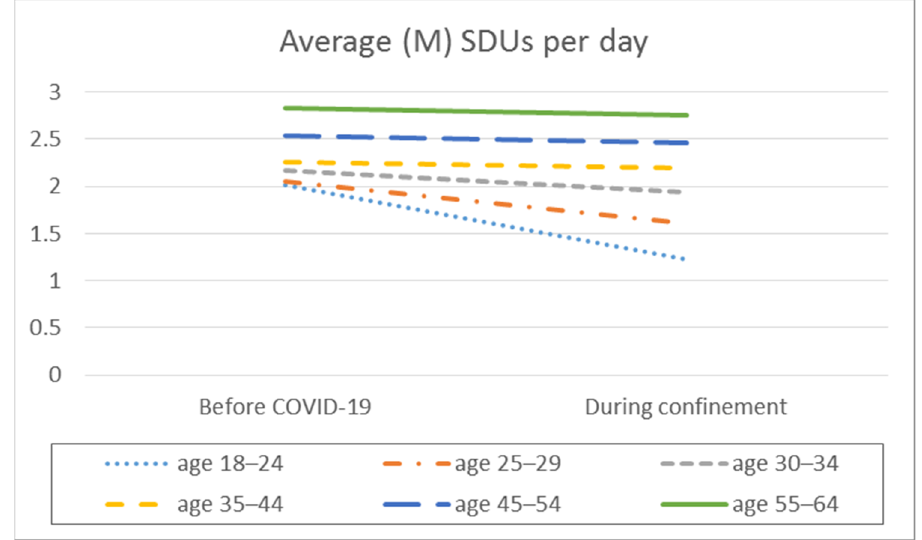
Figure 4. Average number of SDUs per day by age before the pandemic and during COVID-19 con- finement.